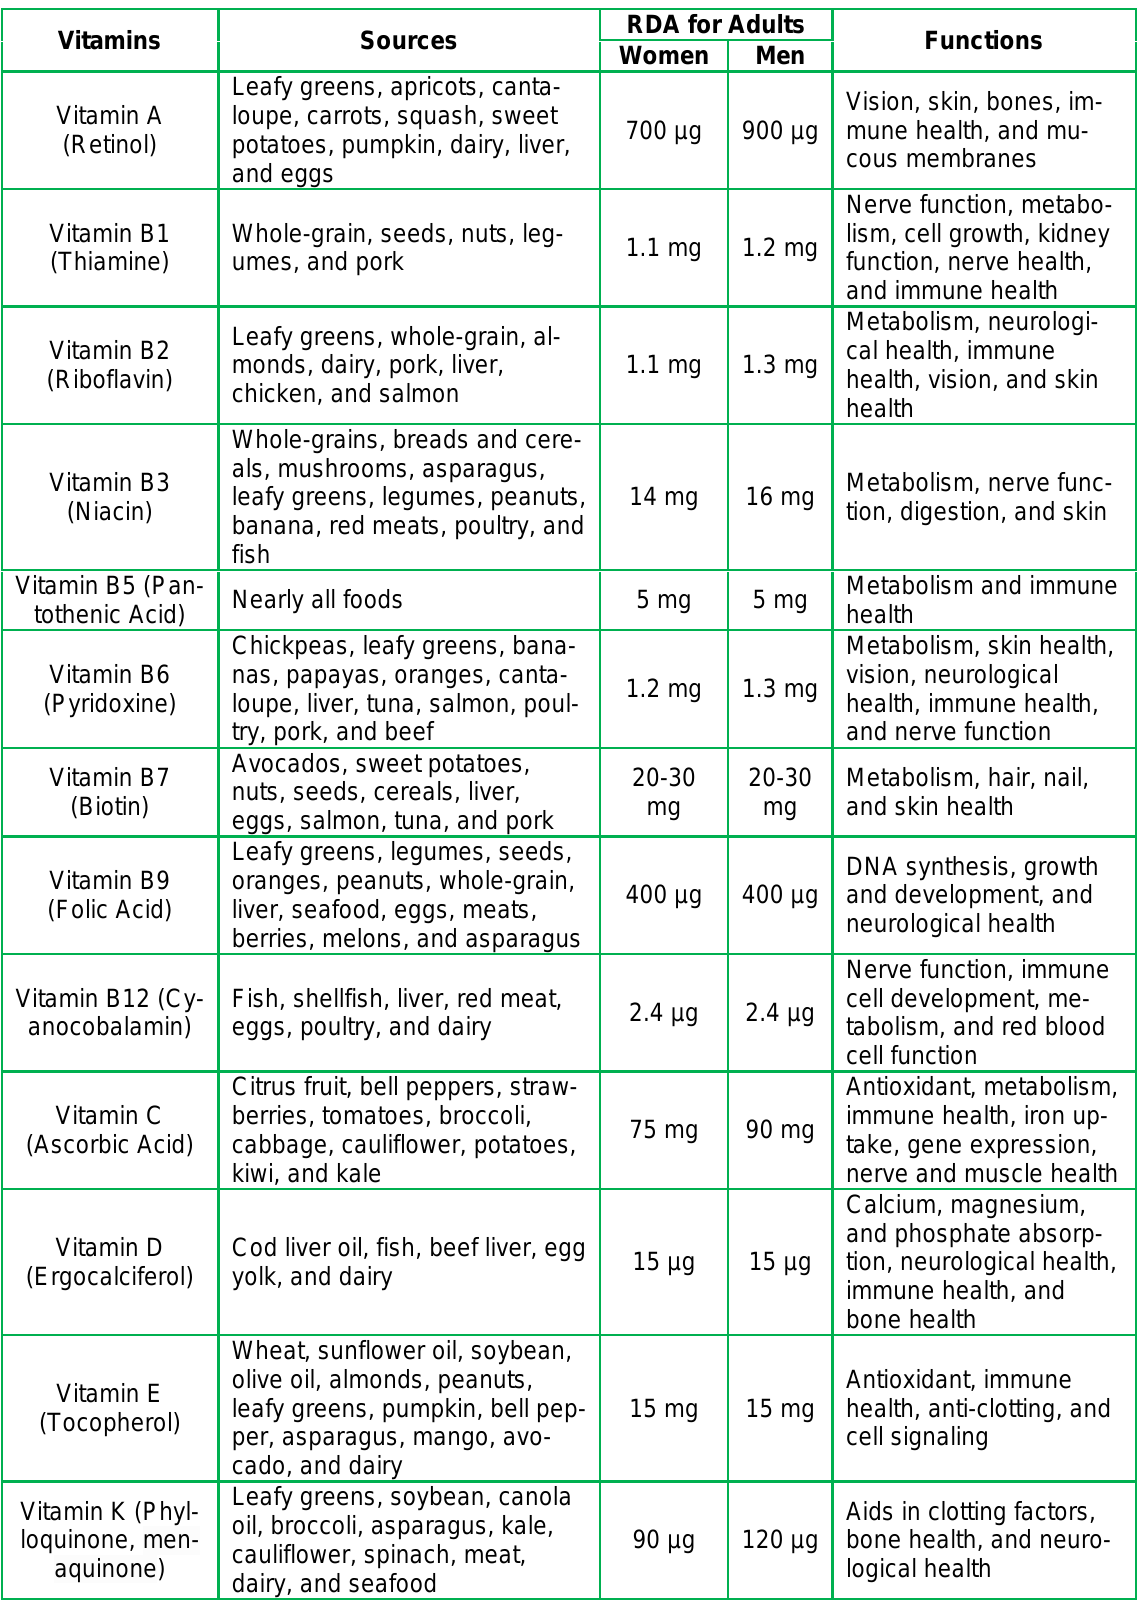
Table 1: Vitamins, their major sources, RDA values for adults, and various functions